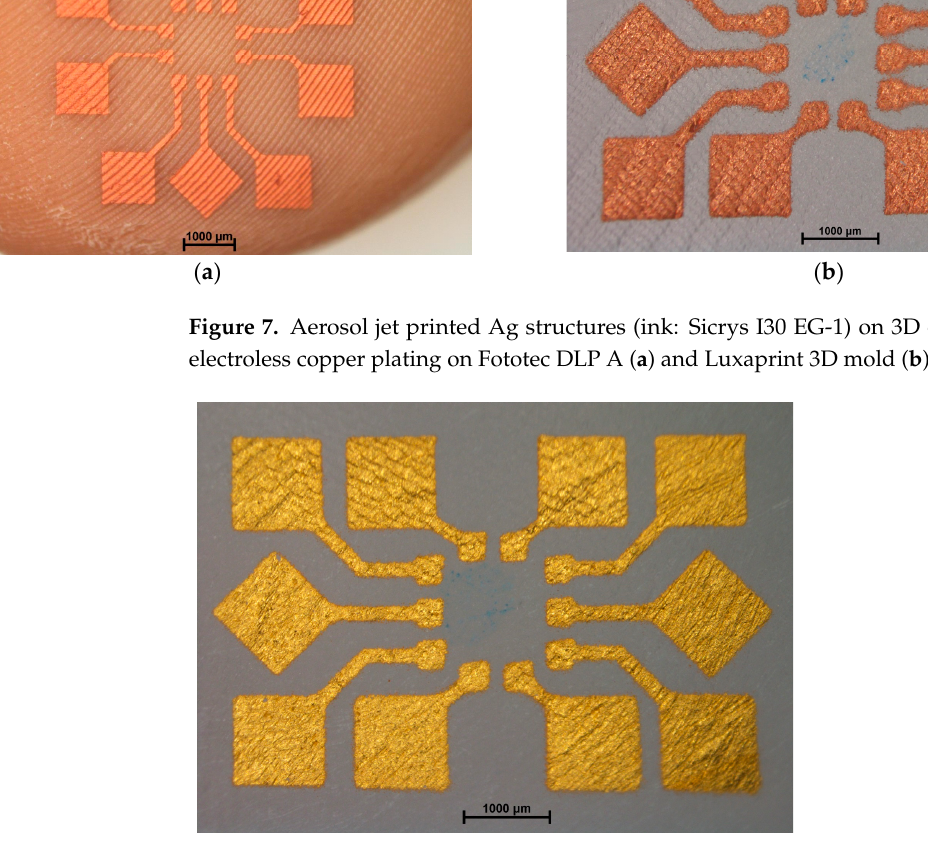
Figure 8. Aerosol jet printed Ag structures (ink: Sicrys I30 EG-1) on 3D ear mold substrate (Luxaprint 3D mold) after electroless plating with copper, nickel and gold.